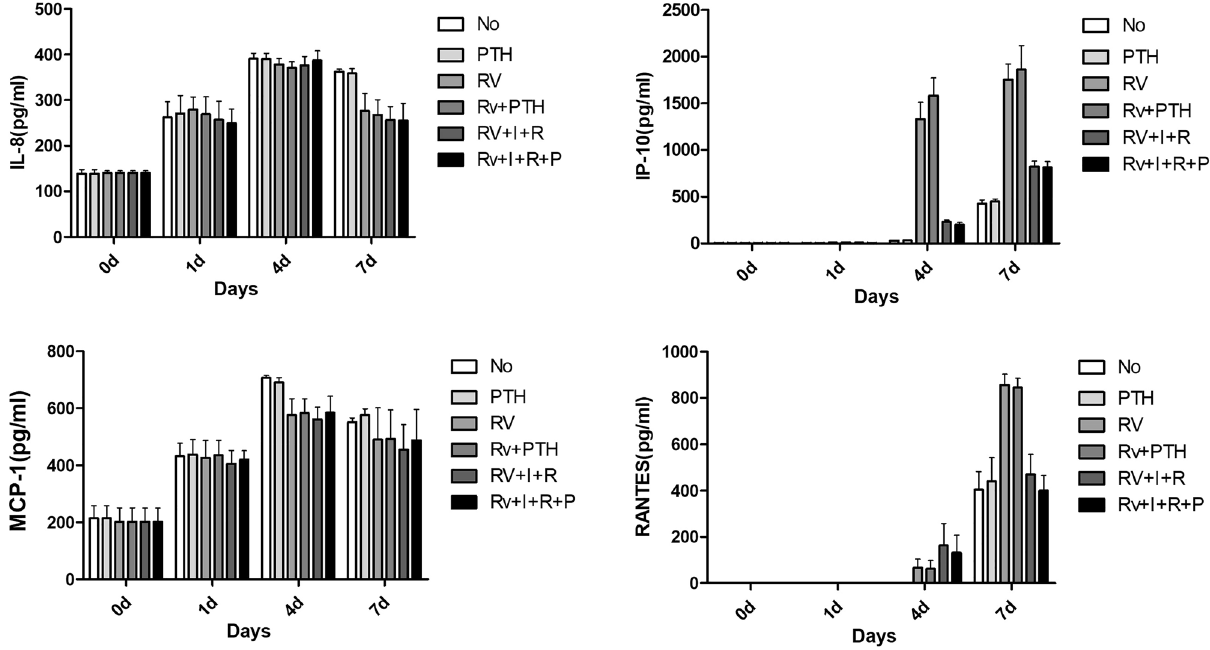
Figure 4. Enzyme-linked immunosorbent assay (ELISA) results of four representative chemokines related to pathologic inflammatory conditions in osteoblasts. Abbreviations: INH, isoniazid; IL-8, interleukin-8; IP-10, interferon γ-induced protein-10; MCP-1, monocyte chemoattractant protein-1; P, teriparatide; PTH, teriparatide; RIF, rifampin; RANTES, regulated upon activation normal, T cell expressed and presumably secreted; RV, Mycobacterium tuberculosis H37RV strain